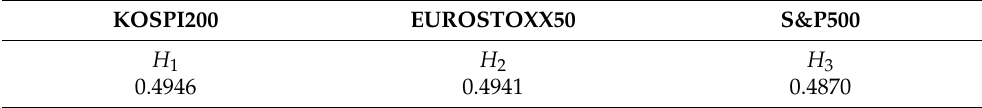
Table 2. Hurst exponents for three-asset step-down ELS calculated by GHE